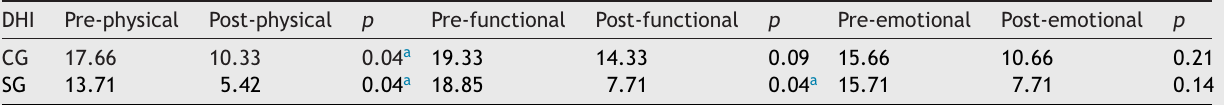
Numerical values of means obtained on the Dizziness Handicap Inventory (DHI) scale before and after training by the CG and SG.